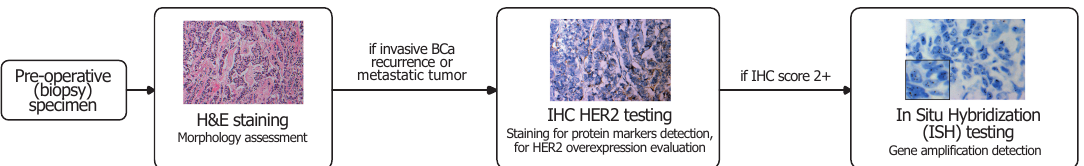
Figure 1. Schema of the process of BCa HER2 evaluation, involving H&E staining, IHC testing and, in specific cases, ISH testing. The proposed method aims to evaluate HER2 using only H&E stained slide images. Image examples were adapted from